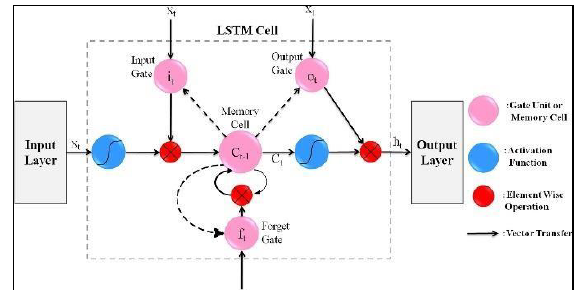
Fig.5. Internal architecture of LSTM